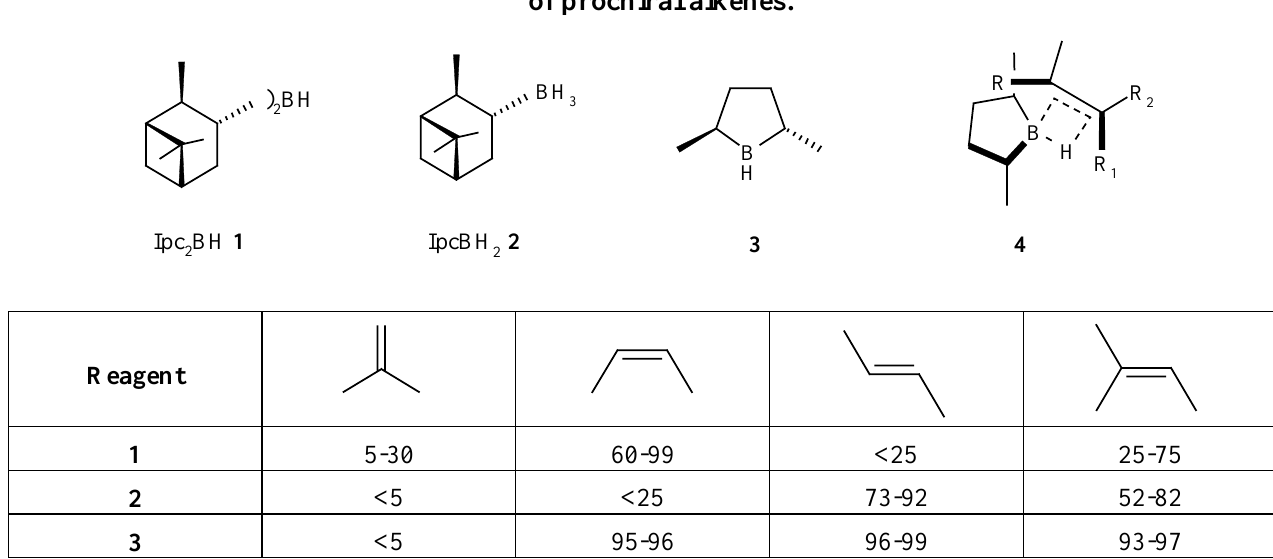
Scheme 1 : Hydroboration reagents and typical % e.e. for the hydroboration of prochiral